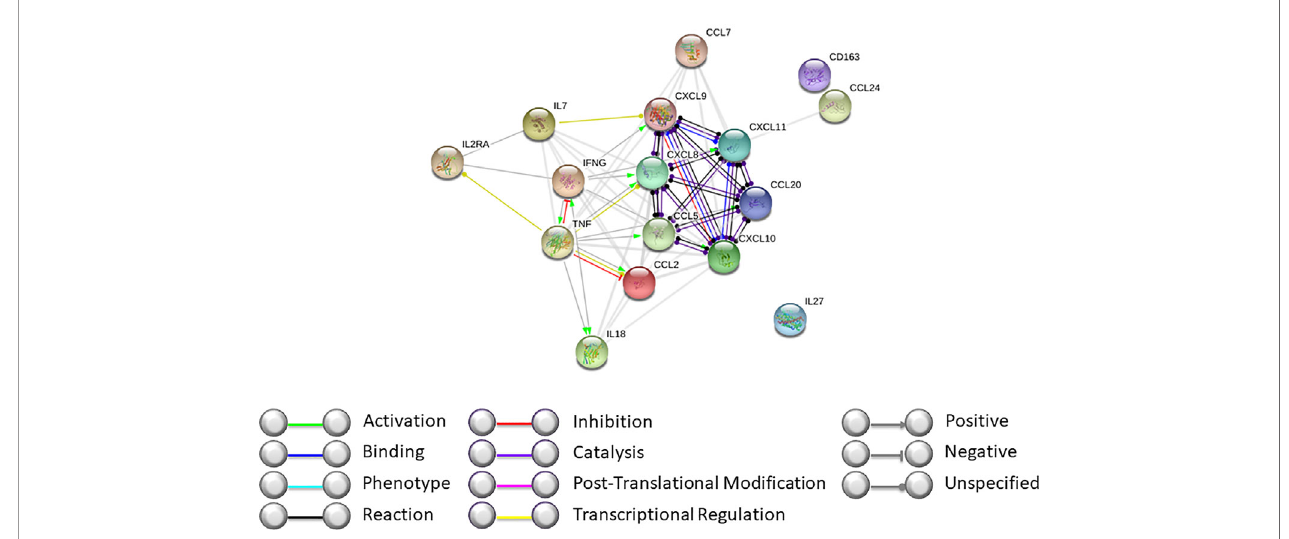
FIGURE 4 | Interactome analysis on identi fi ed cytokines and chemokines modulated during GF was performed using STRING software (https://string-db.org). Interactome of cytokines and chemokines modulated during GF after HSCT with high con fi dence